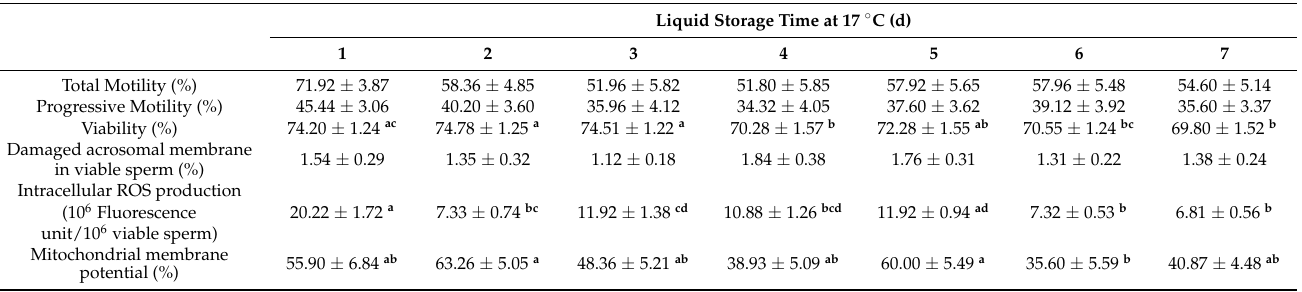
Table 1. Boar sperm quality and functionality during liquid storage at 17 ◦ C. Data (mean ± SEM) from 25 ejaculates of 18 Duroc